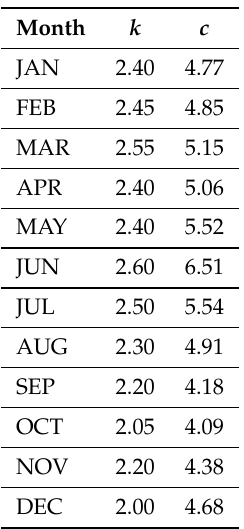
Table 1. Weibull parameters for monthly wind speed distribution in